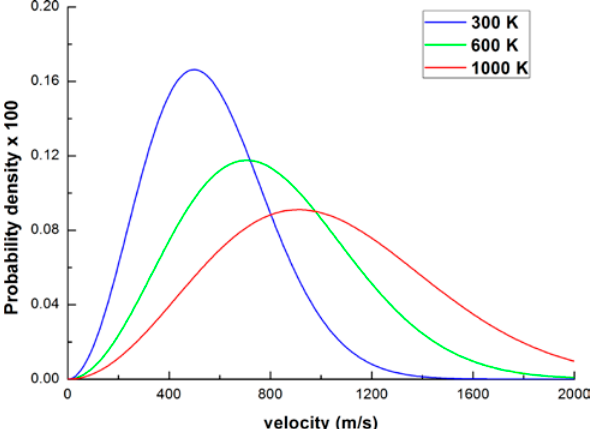
Figure 2. Maxwell-Boltzmann probability distribution of atomic velocities (see Eq. 4) at T = 300 K for a set of 200 atoms with mass m specified in the legend. The MD time step was 1 fs.